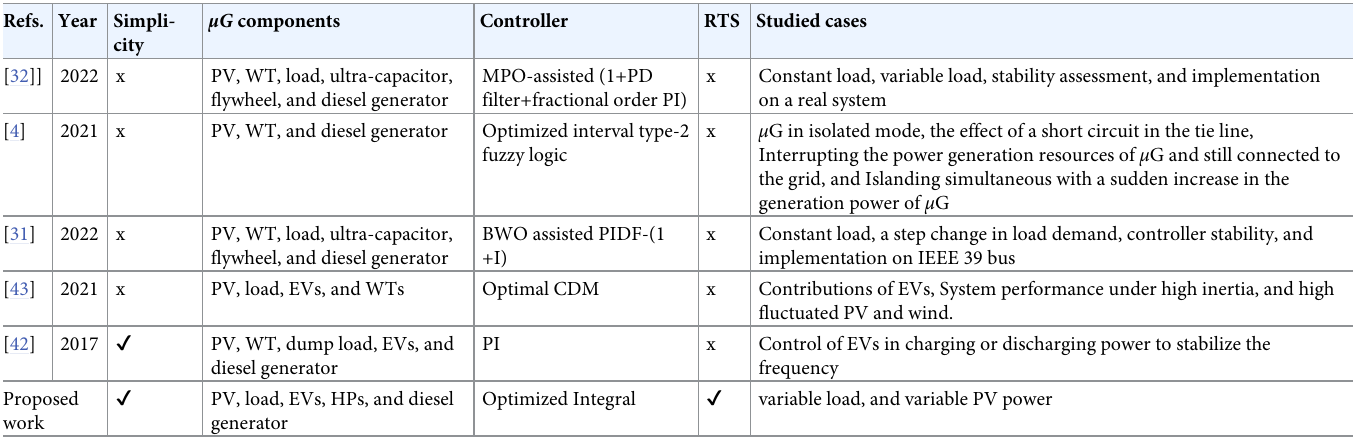
Table 3. A comparison with previously published papers in this research